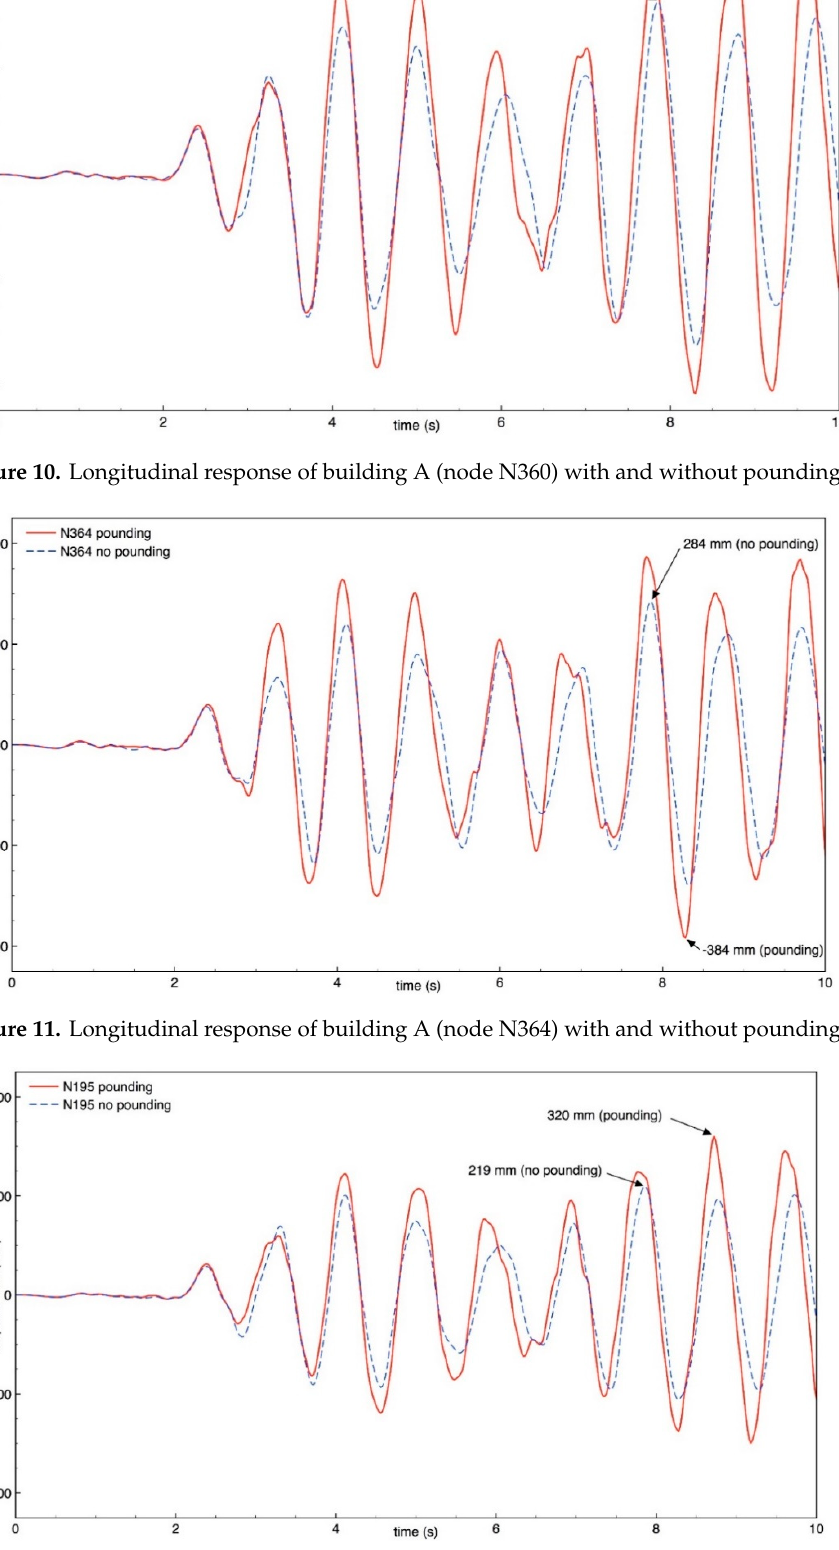
Figure 12. Longitudinal response of building A (node N195) with and without pounding.